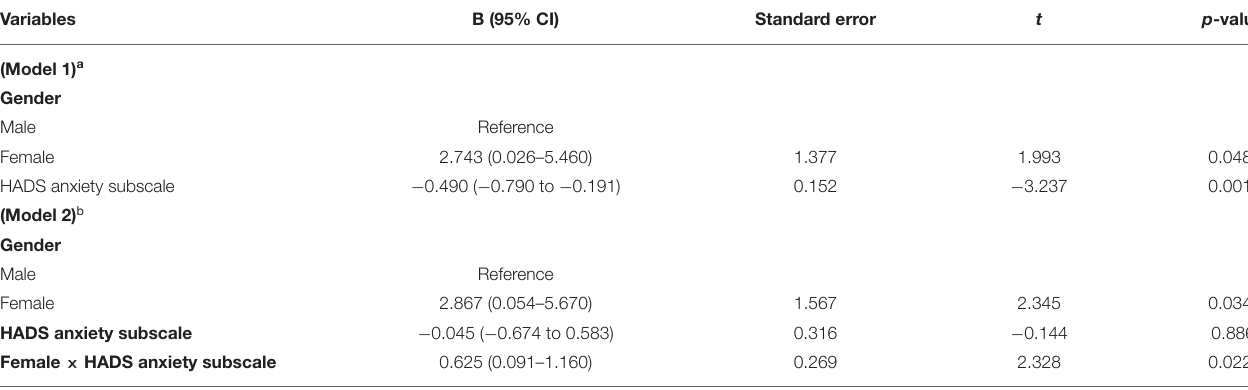
TABLE 6 | The moderating effect of gender on the association between the HADS anxiety subscale score and total PTGI-SF score. Variables